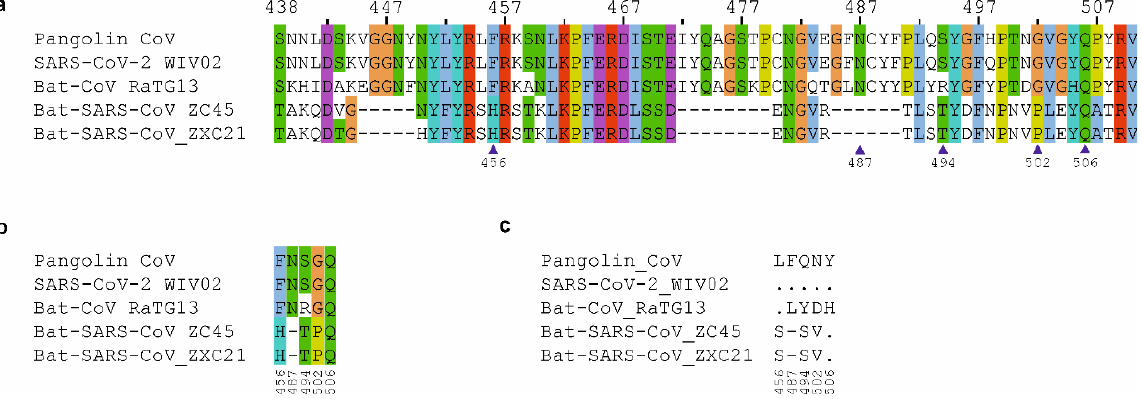
Figure 1. Analysis of the RBD sequence . ( a ) Multiple sequence alignment showing RBD of S protein from Pangolin CoV (GISAID accession ID: EPI_ISL_410721), SARS-CoV-2_WIV02 (EPI_ISL_402127), and Bat-CoVs (Bat-CoV_RaTG13, Bat-SARS-CoV_ZC45 and Bat-SARS-CoV_ZXC21). Conserved similar amino acids are colored in the alignment. The five critical residues for human ACE2 binding (as mentioned in [11] with respect to SARS-CoV-2_WIV02 coordinates) are indicated by arrowheads below the alignment. Sequence gaps are indicated with dashes. ( b ) Central part of the alignment from ( a ) showing the critical residues. ( c ) Part of alignment from Xiao et al. [11] Figure 7b. This shows only the mentioned critical residues. Identical residues are indicated with a dot.